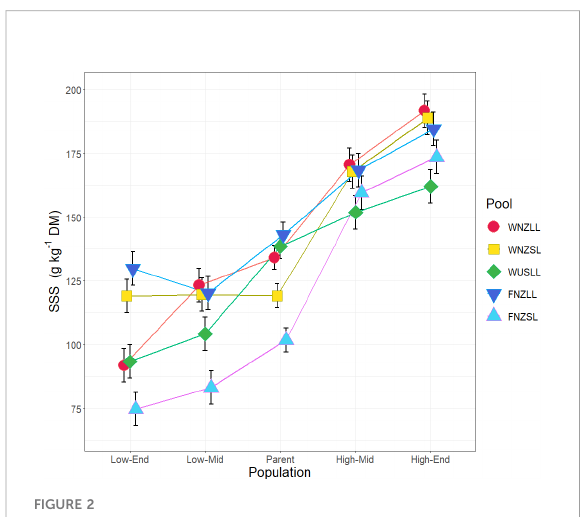
FIGURE 2 Population fi tted values (adjustment for treatment, block, row and column effects) and standard error, for soluble sugars and starch (SSS) as a measure of water-soluble carbohydrate (WSC). Populations are grouped by pool as indicated by colour and symbol combinations. The x -axis indicates a timeline by generation, where: Low, low WSC; High, high WSC; End, End generation; Mid, Middle generation; Parent, Parent generation. Population means for SSS are based on n = 20 –